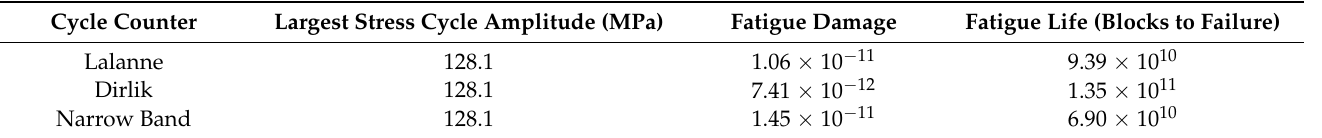
Table 8. Fatigue life results for the 0.75 mm lattice blade.